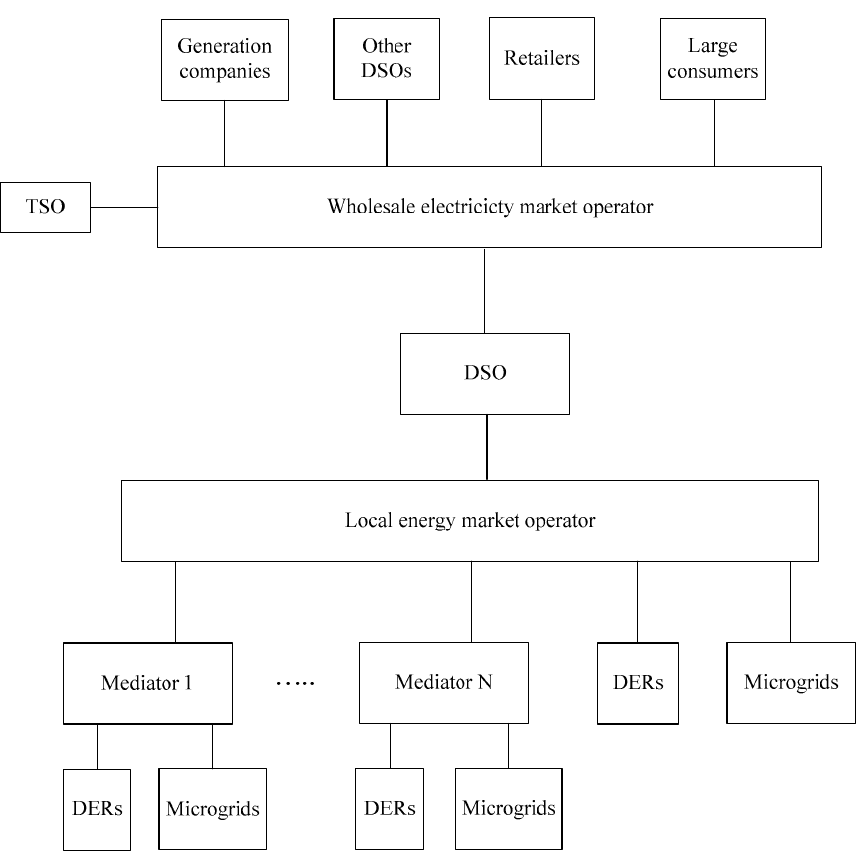
Figure 1. Possible future framework of wholesale electricity market and local energy market with mediators, distributed energy resources, and microgrids.